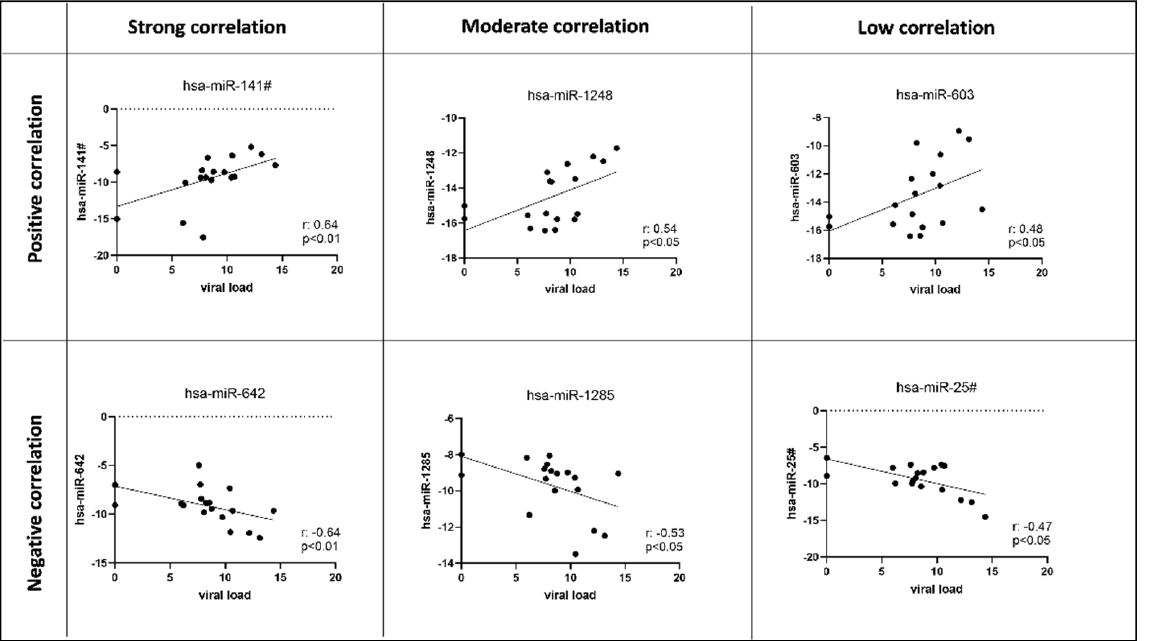
Figure 3. Scatter plot showing statistically significant (two-tailed) Spearman positive (hsa-miR-141#, hsa-miR-1248, hsa-